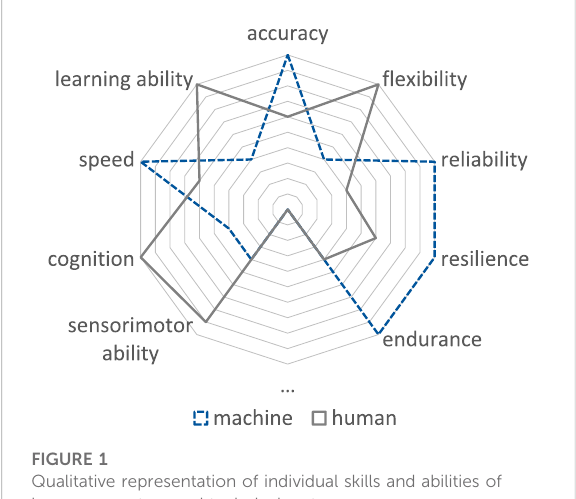
FIGURE 1 Qualitative representation of individual skills and abilities of human operators and technical